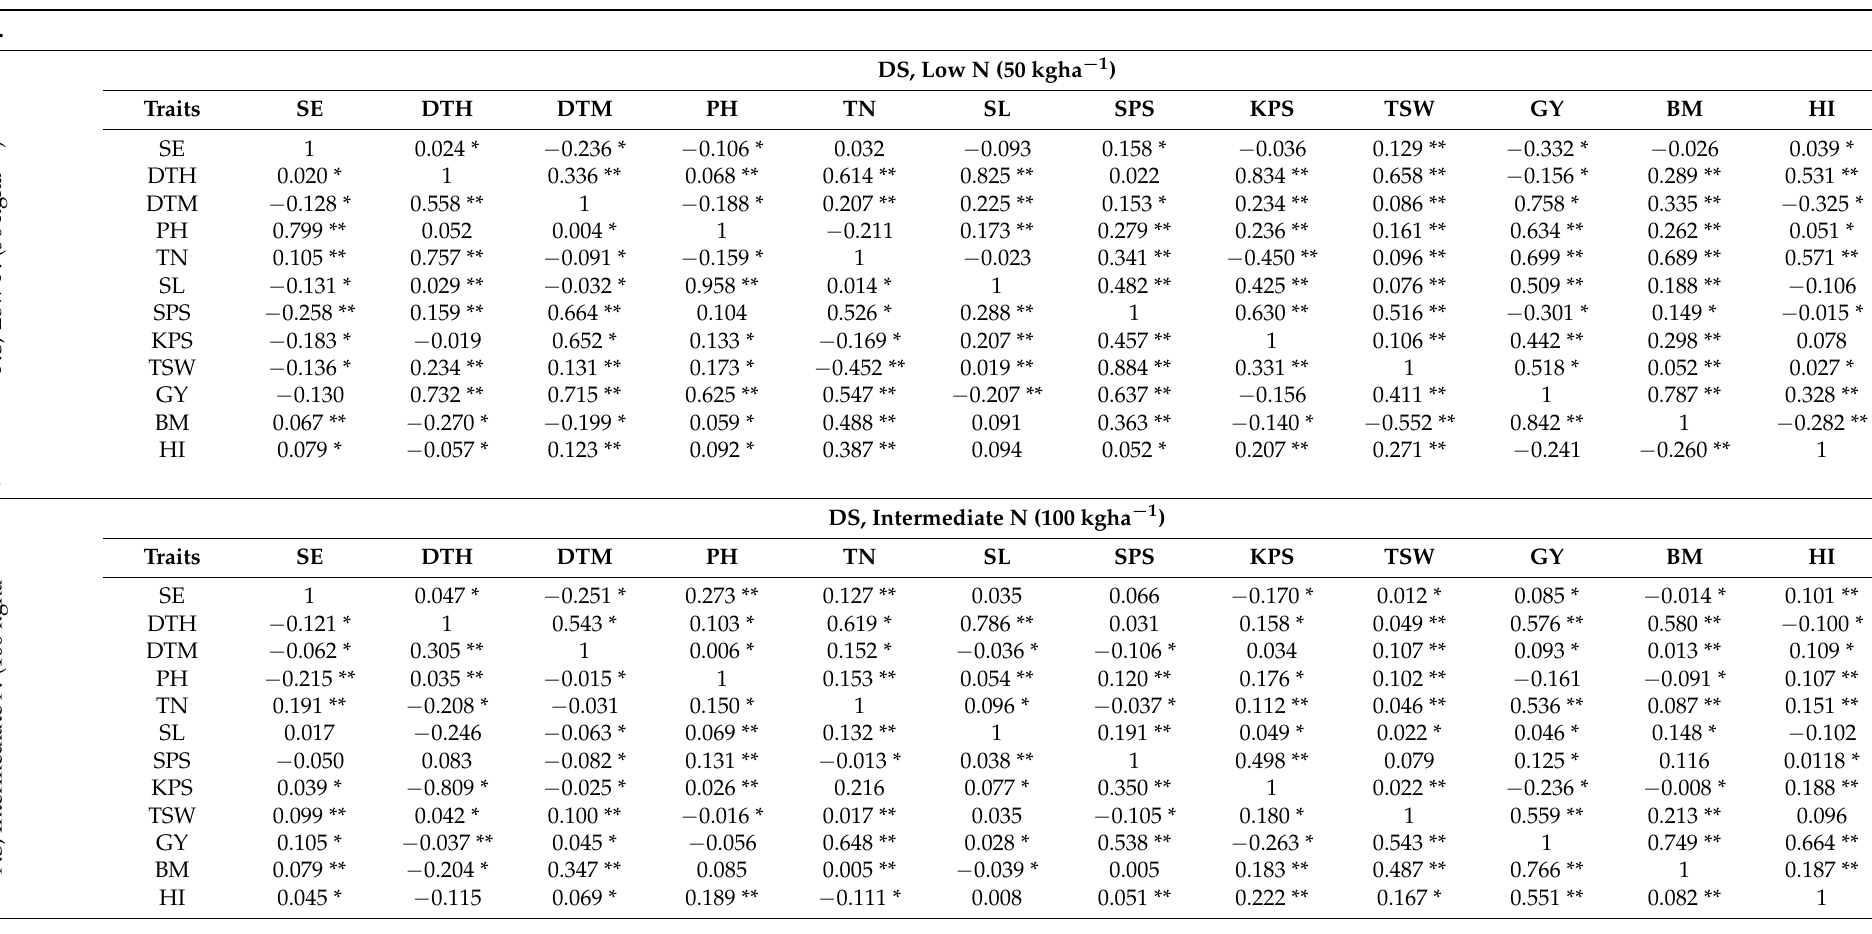
Table 6. Pearson’s correlation coefficients ( r ) revealing the associations of 12 agronomic traits measured in 50 wheat genotypes evaluated under drought stress (DS) and non-stressed (NS) conditions and three nitrogen